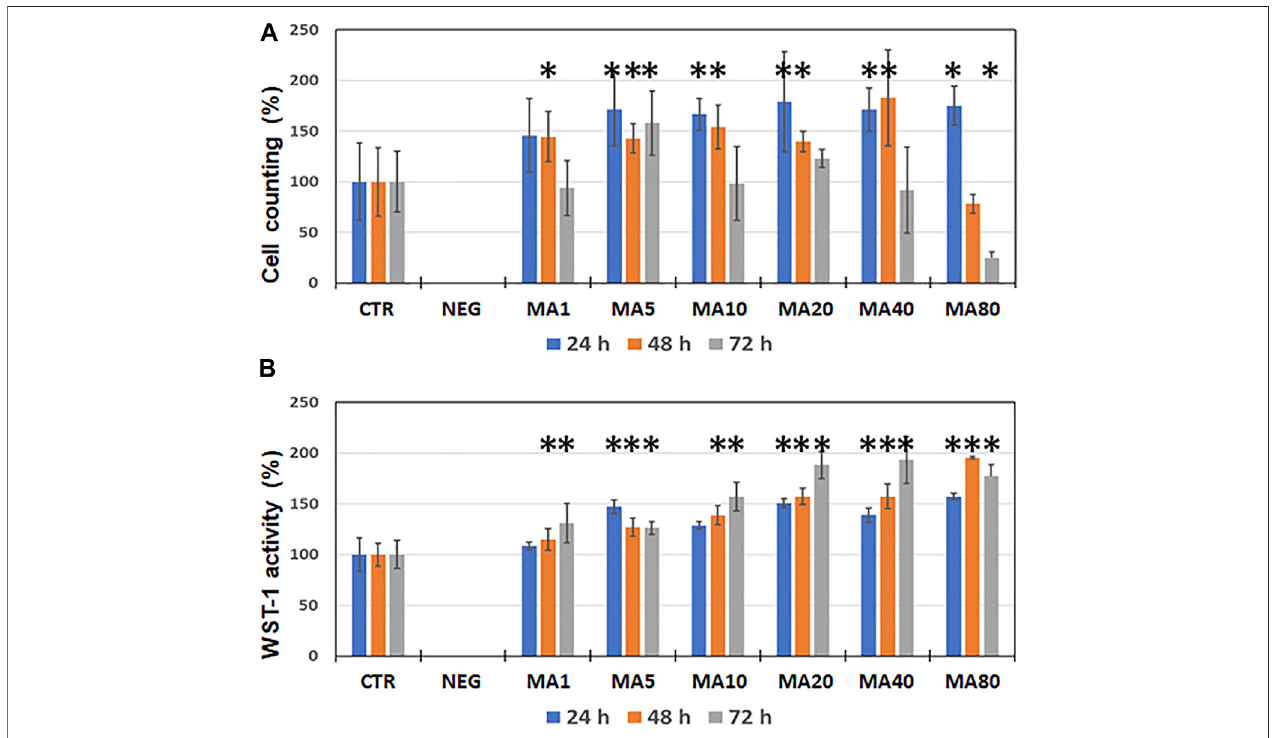
FIGURE 2 | Analysis of cell proliferation of immortalized human keratinocytes cultured for 24, 48 and 72 h as determined by sequential cell number quanti fi cation (panel (A) ) and WST-1 activity (panel (B) ). Results are shown as average percentage values normalized to negative controls (NEG) and positive controls (CTR), which were considered as 0 and 100%, respectively. Error bars correspond to standard deviations. Statistically signi fi cant differences with CTR are labeled with asterisks